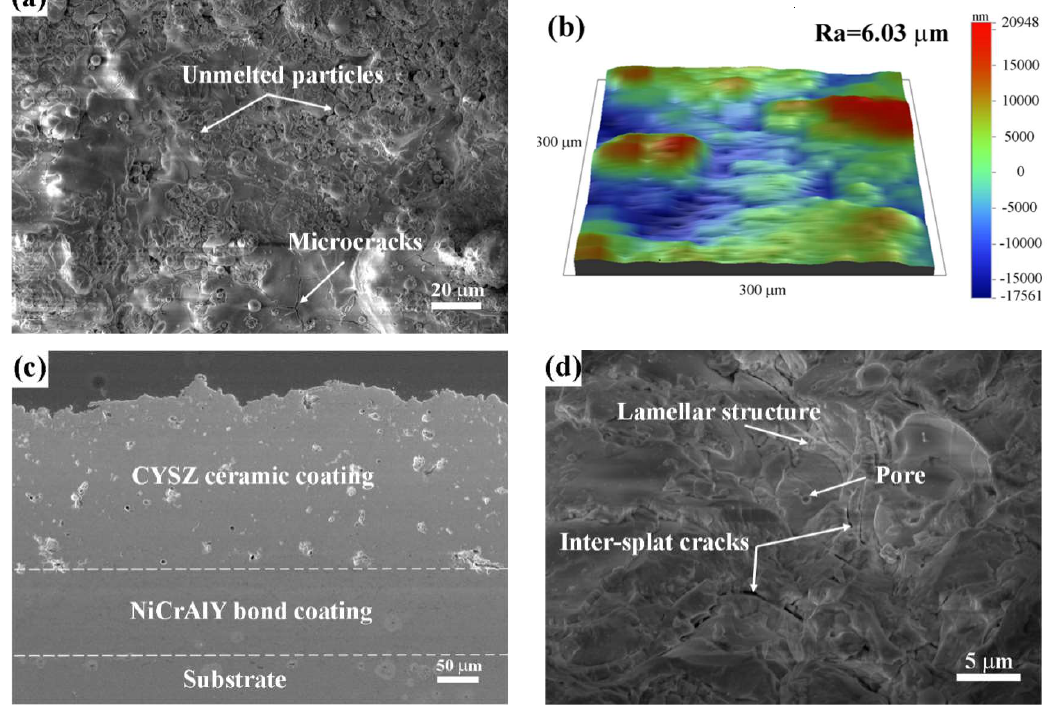
Figure 3. ( a ) Surface morphology, ( b ) surface roughness, ( c ) polished cross section, and ( d ) fracture microstructure of CYSZ ceramic coating in the plasma-sprayed specimen.